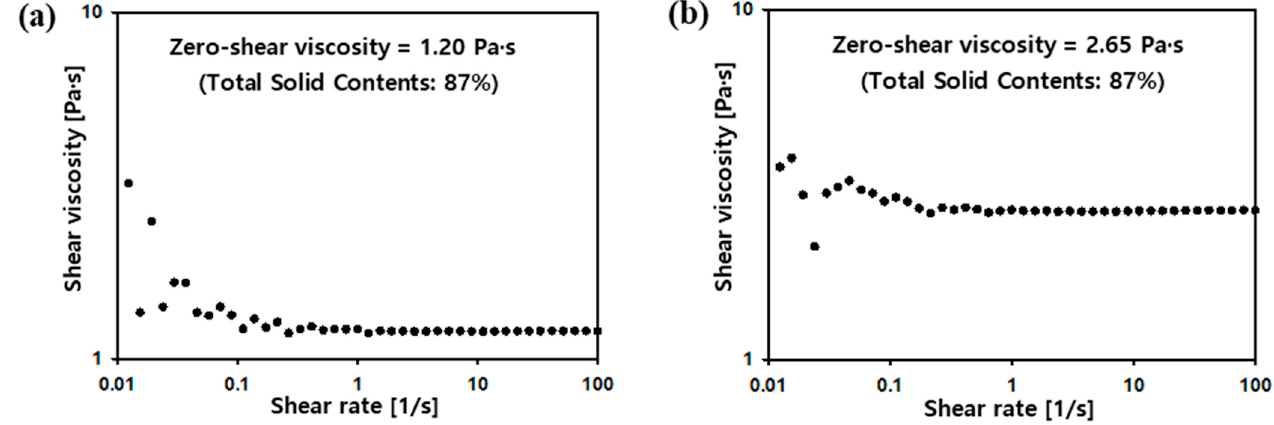
Figure 3. Zero-shear viscosity; ( a ) N-LqBR, ( b )